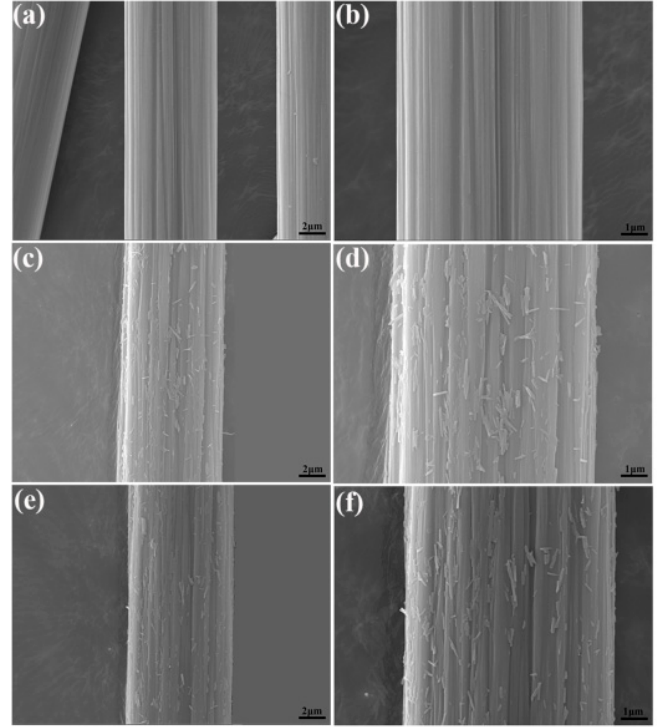
Figure 4. SEM images of different CF surfaces: ( a , b ) untreated CF, ( c , d ) CF–HNT–NH 2 ; and ( e , f ) CF–